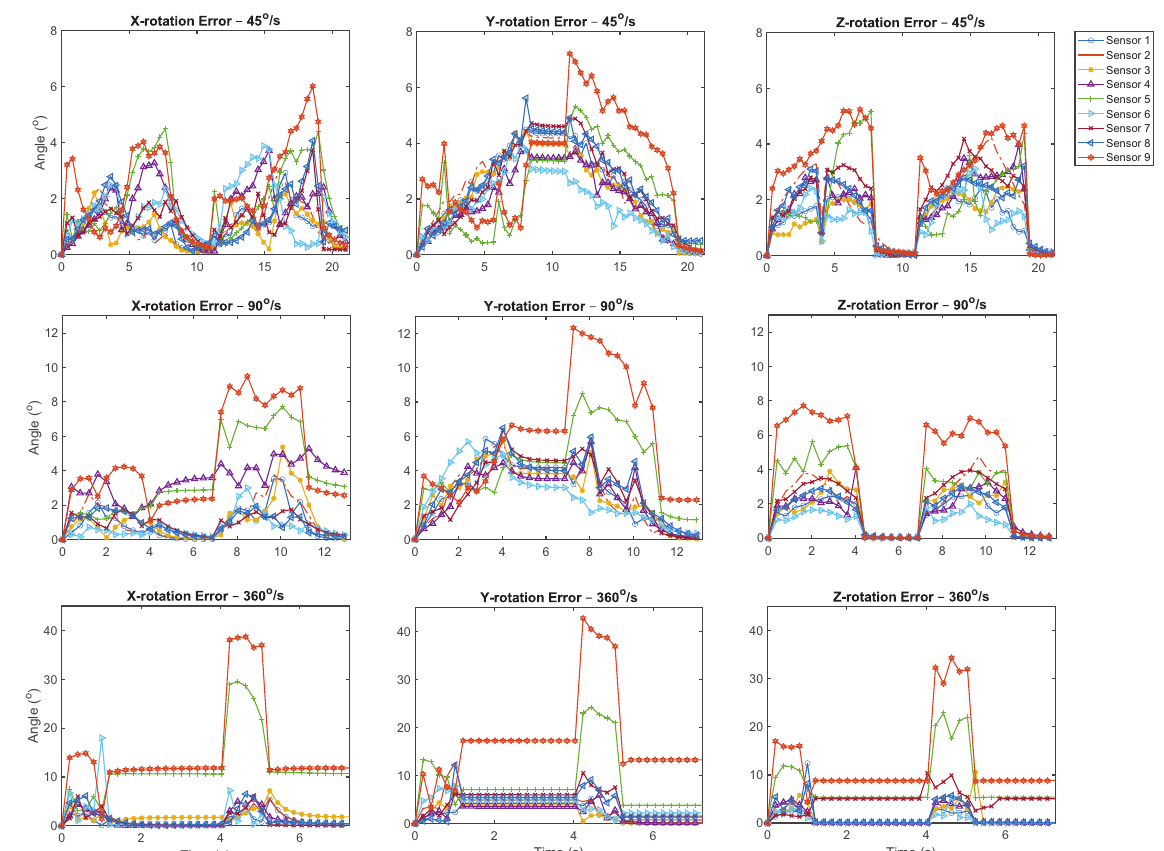
Figure 3. Rotation error of the individual IMUs fused with the Kalman filter without the magnetometer, stratified by axis of rotation and angular velocity.